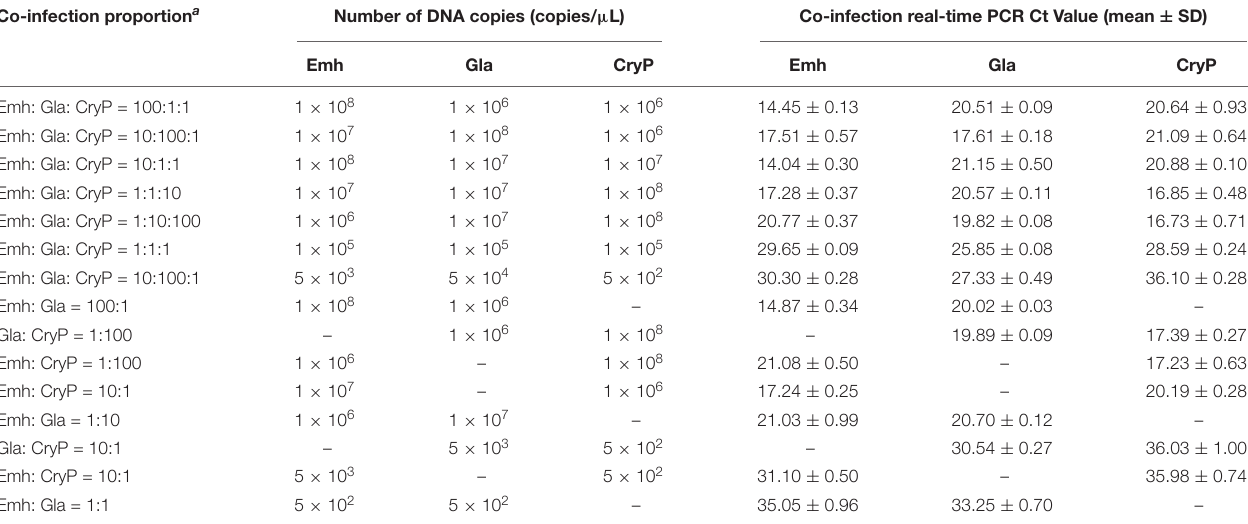
TABLE 5 | The detection of the co-infection models by triplex quantitative PCR (qPCR). Co-infection proportion